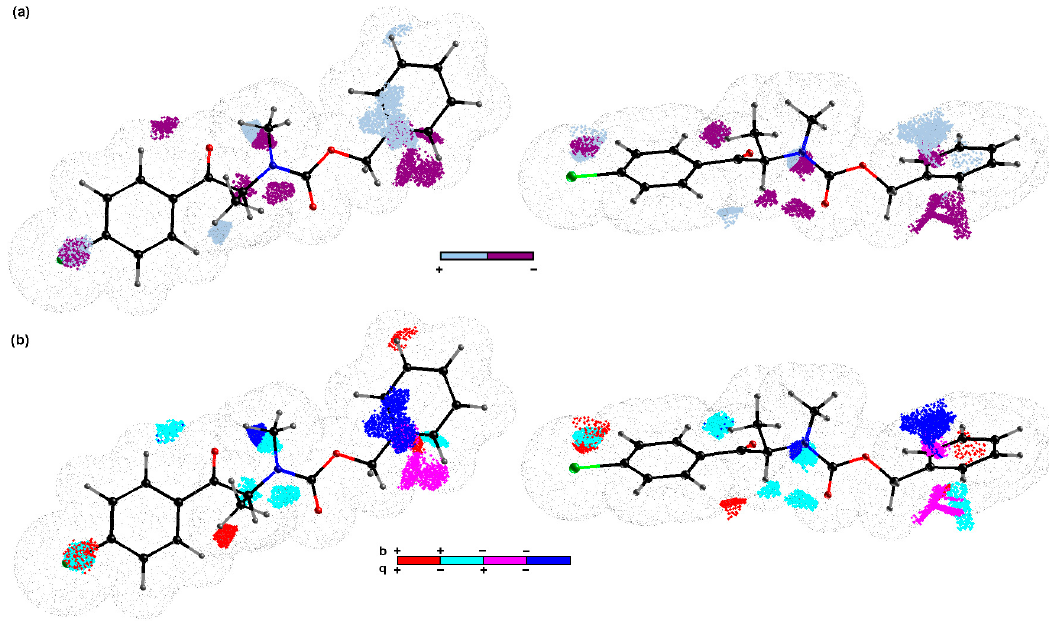
Figure 5. The spatial sectors with the greatest contribution into the BChE inhibitory potency specified as CoMSA IVE-PLS for the selected 30/11 training/test set samplings. Colors indicate their effect ( a ) and the four possible combination of the mean charge q and correlation coefficient b values ( b ). Reference compound 32 is plotted in two different orientations.